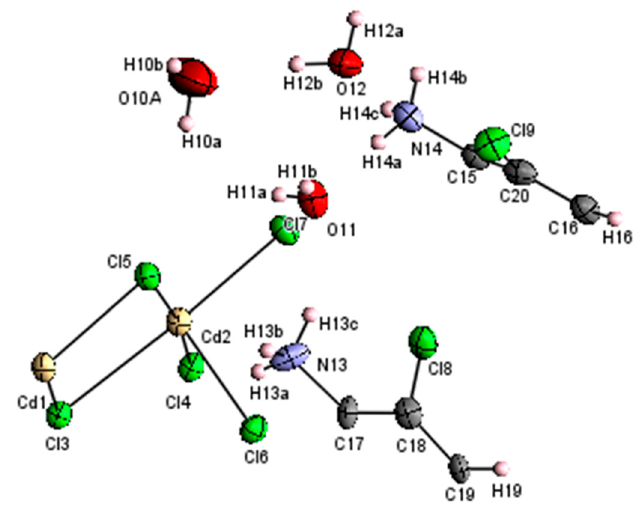
Figure 3. ORTEP representation of (C 6 H 8 Cl 2 N 2 ) 2 [Cd 3 Cl 10 ]·6H 2 O.